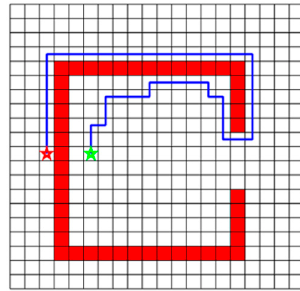
Figure 6. One example of the tortuous path by the original DC-space method. A red star denotes the start point, and a green star denotes the target